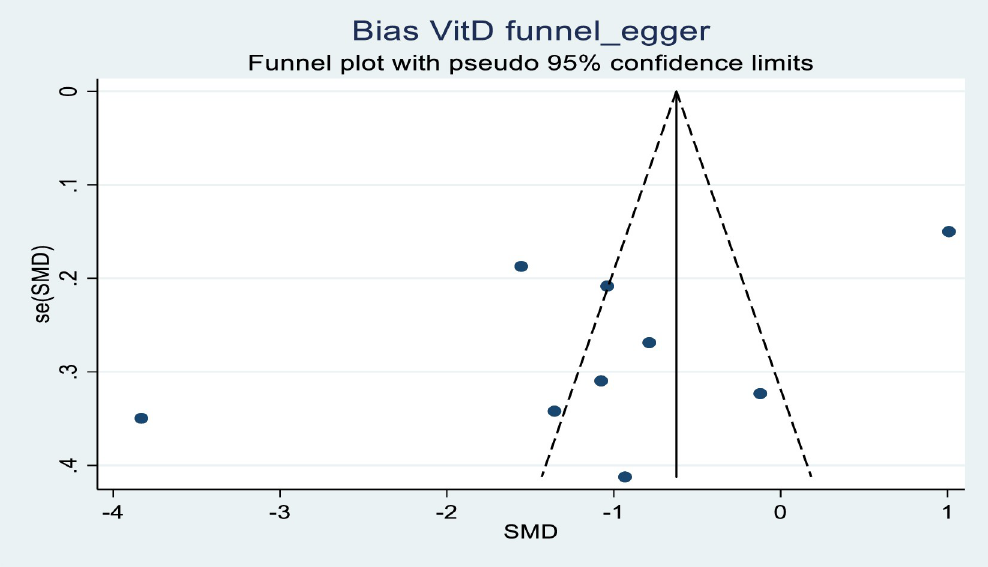
Fig 4. Funnel plot of standard mean difference of vitamin D levels against standard error of mean difference at CI 95% showing asymmetry in eight highly scattered studies due to publication bias.